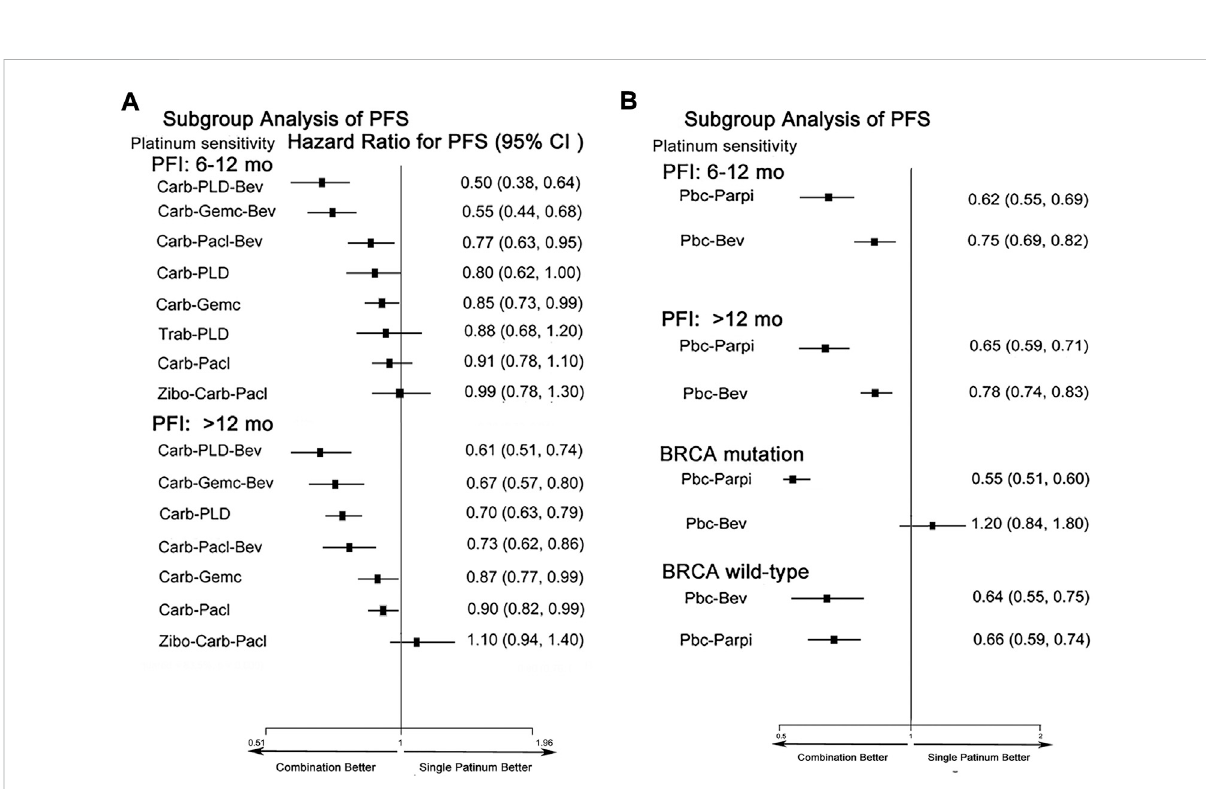
FIGURE 6 Forestplotsofsubgroupanalysisofprogression-freesurvivalinpatientswithPSROC. (A) Hazardratiosand95%CIsforprogression-freesurvival in initial treatments. (B) Hazard ratios and 95% CIs for progression-free survival in maintenance treatments. Hazard ratios < 1.00 provide a better survival bene fi